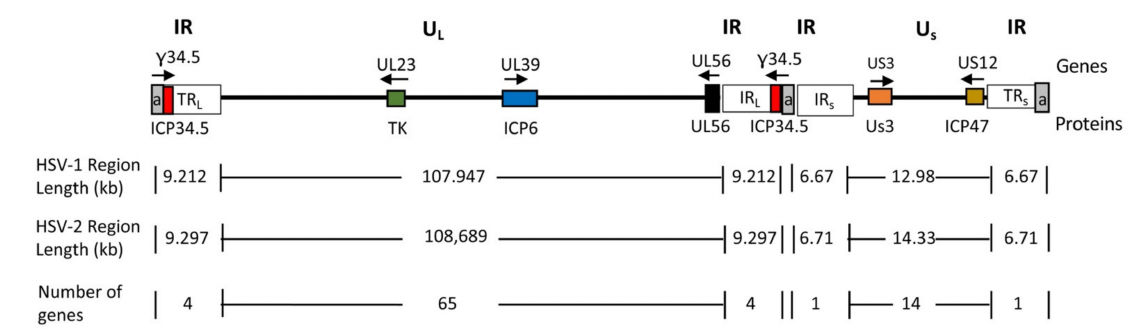
Figure 3. Schematic diagram of HSV genome. The genome consists of unique long (U L ) and short (U S ) sequences bracketed by terminal (TR L and TR S ) and internal (IR L and IR S ) inverted repeat (IR) sequences. The number of a sequence repeats (a, in gray) is variable. Genes relevant for tumor-specificity are shown as colored boxes and their names are indicated above the genome line; the gene product names are indicated below the genome line. Arrows indicate the direction of